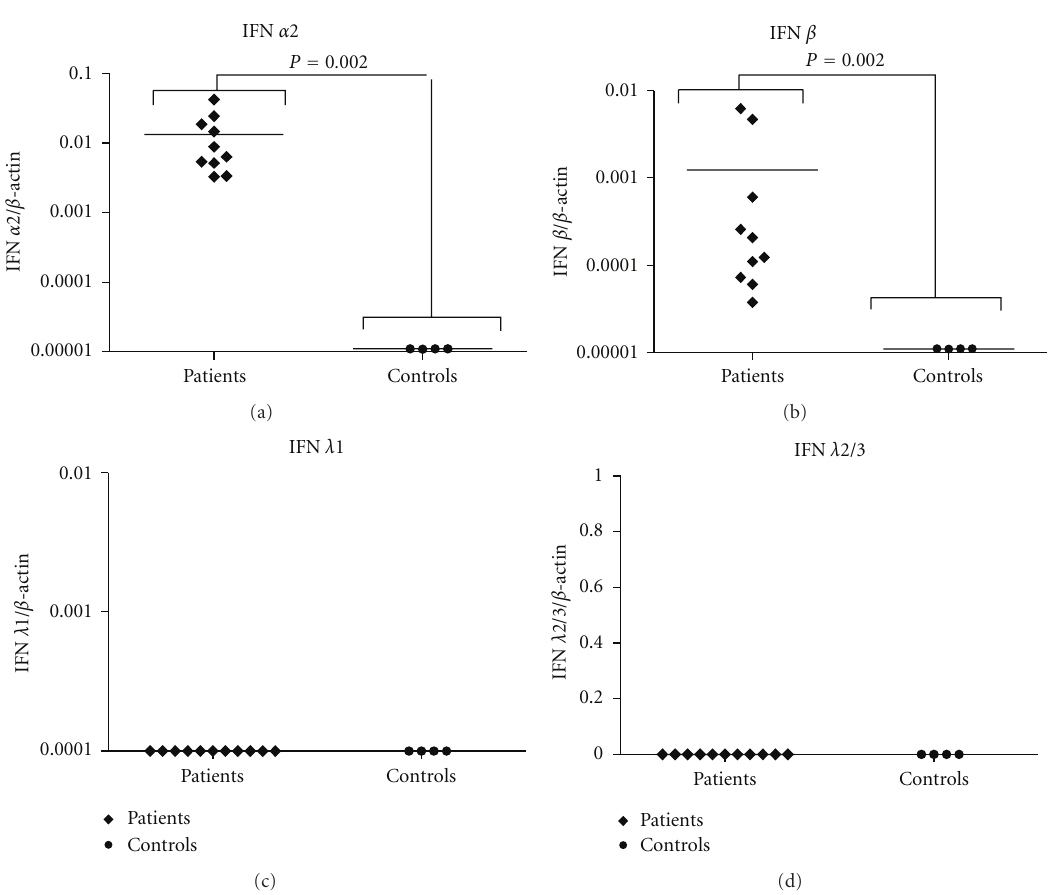
5 (cid:2) -AACTGCTTCCGACAATCAAC-3 (cid:2) and reverse 5 (cid:2)